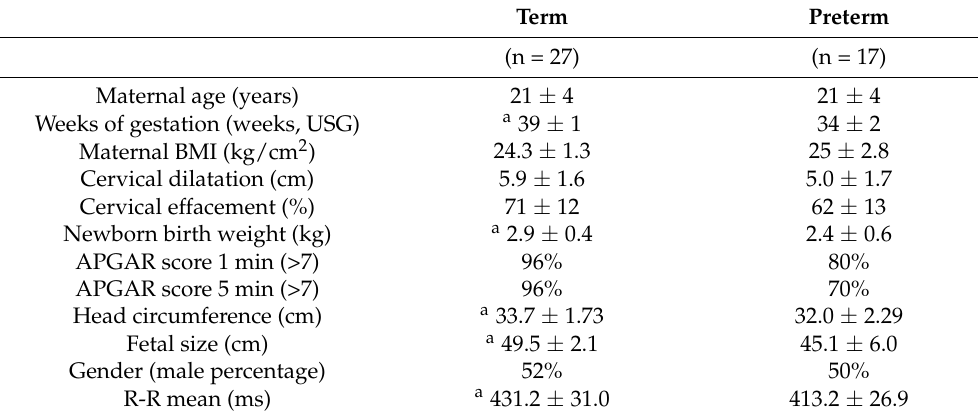
Table 1. Clinical characteristics of the mother and newborn.